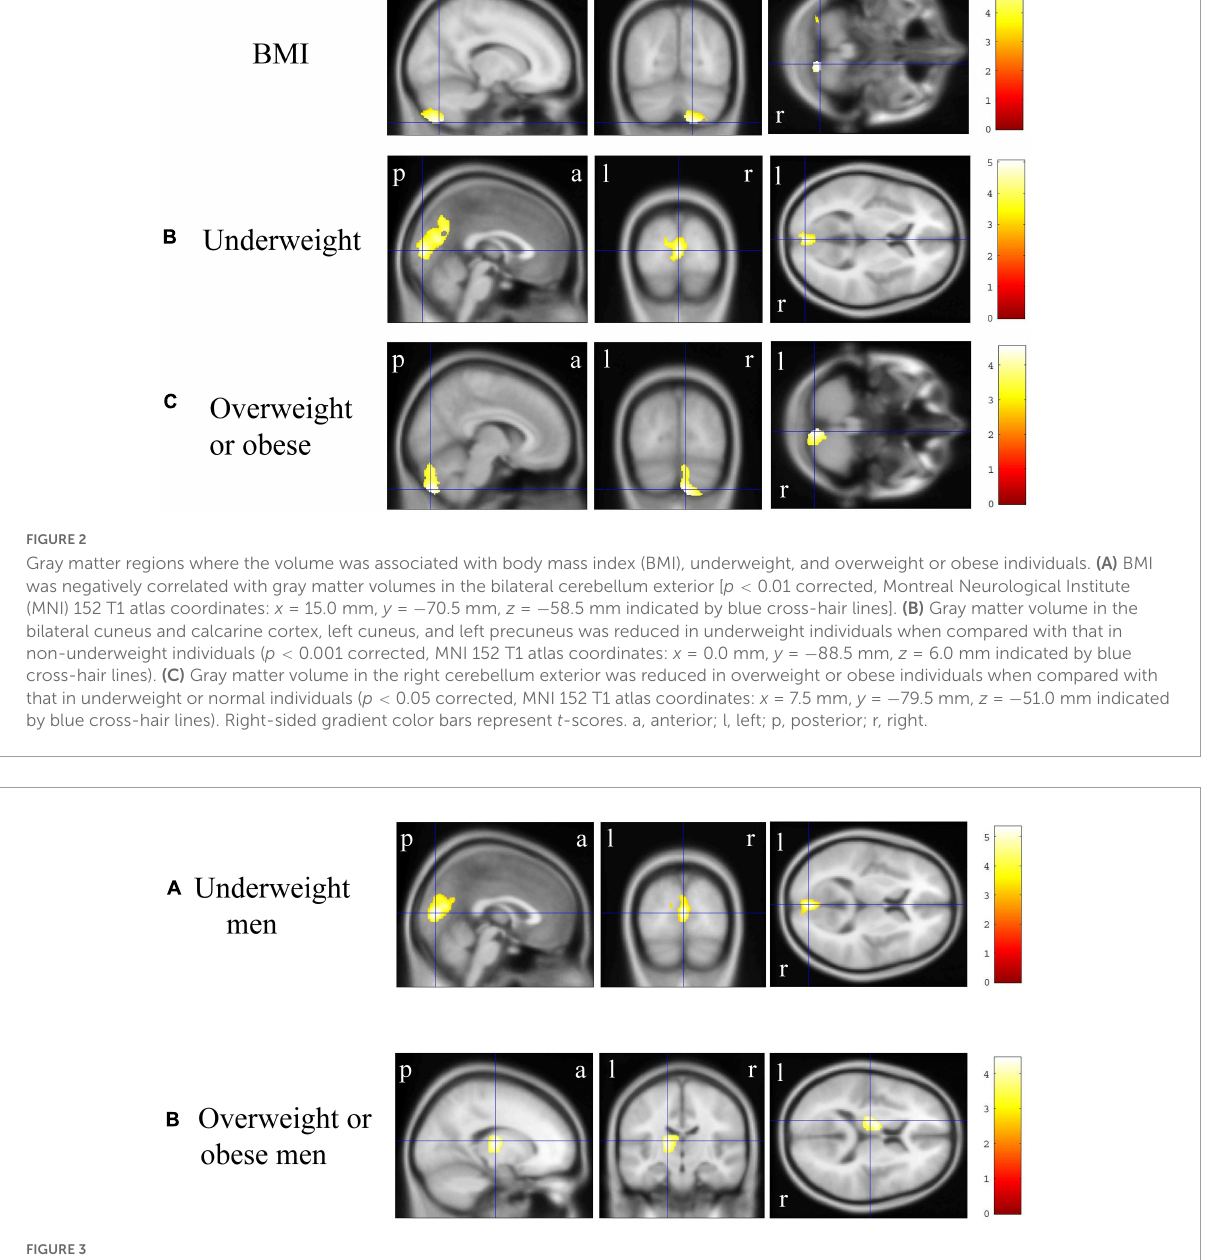
size (Eliot et al., 2021). This study suggests that individuals who are biased in terms of BMI may show population-specific gray matter volume reductions, considering relatively low